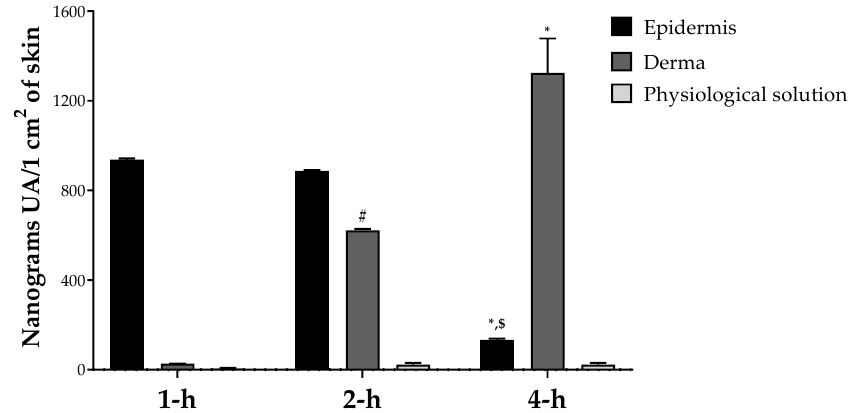
Figure 4. UA in vitro skin permeation study; values are presented as means ± Dev. st of three replicates. Data were analyzed with two-way ANOVA followed by Tukey’s posthoc test; * p < 0.01 4-h vs. 1-h, # p < 0.01 2-h vs. 1-h, $ p < 0.01 4-h vs. 2-h in the same group.